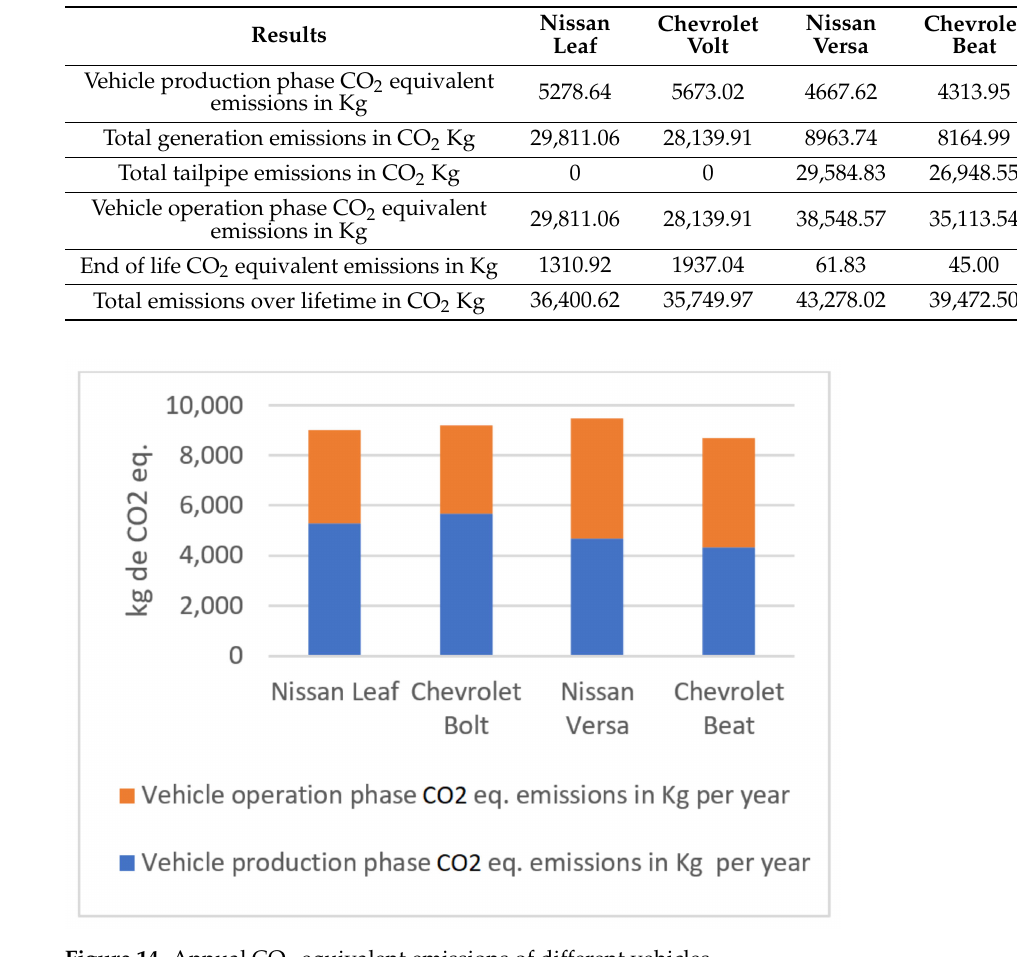
Figure 13. CO 2 equivalent emissions of different vehicles. Table 3. Average emissions for an 8-year period.